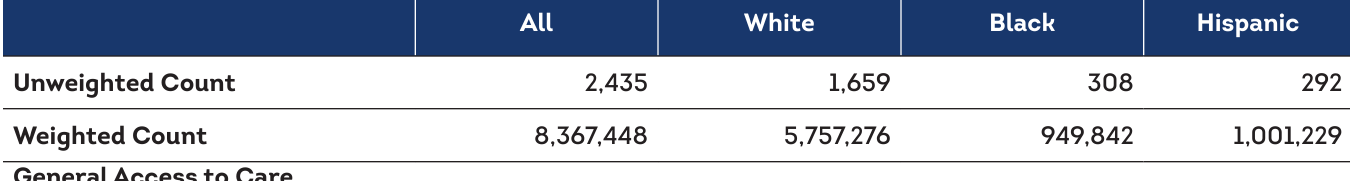
Table A3: Access to care and propensity to seek care, by race/ethnicity All White Black